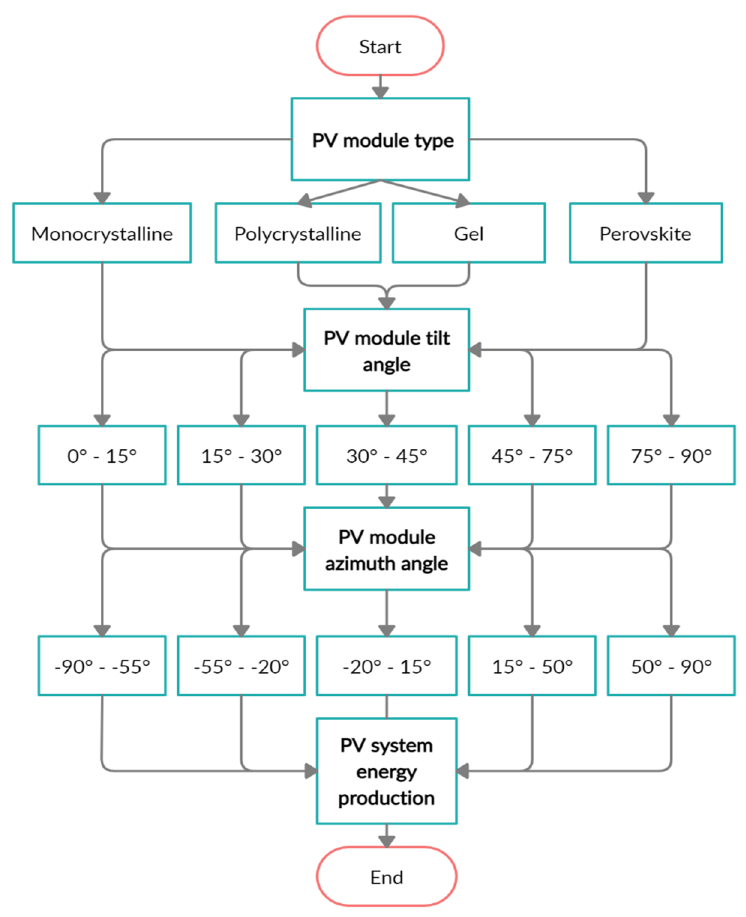
Figure 16. Flowchart of the prepared application for smart devices.